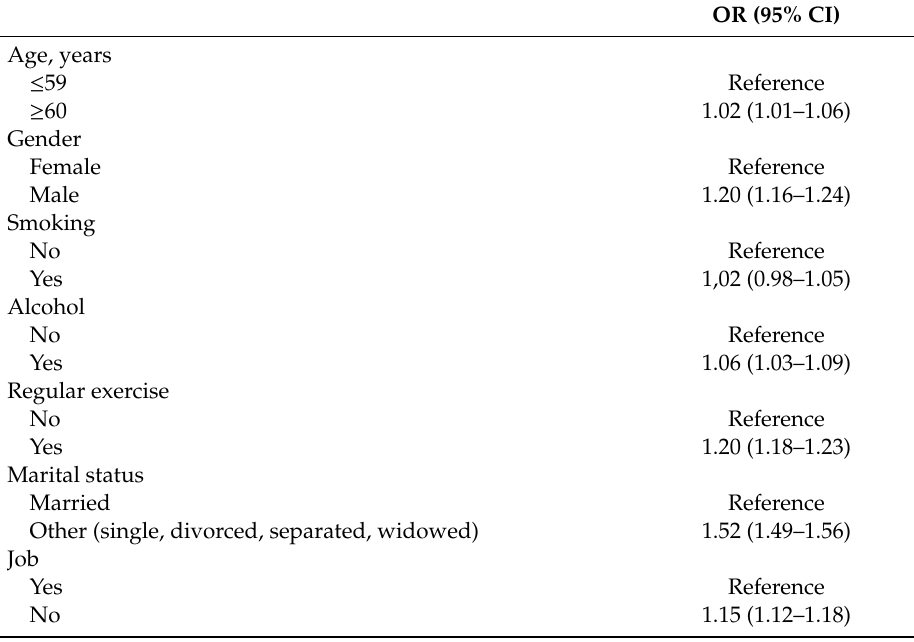
Table 3. Factors associated with overall low knowledge for cardiovascular